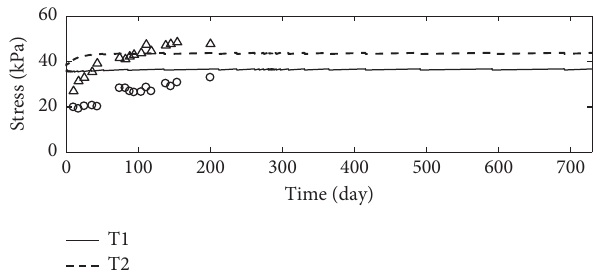
Figure 7: Comparison of soil pressure simulation results and field monitoring.